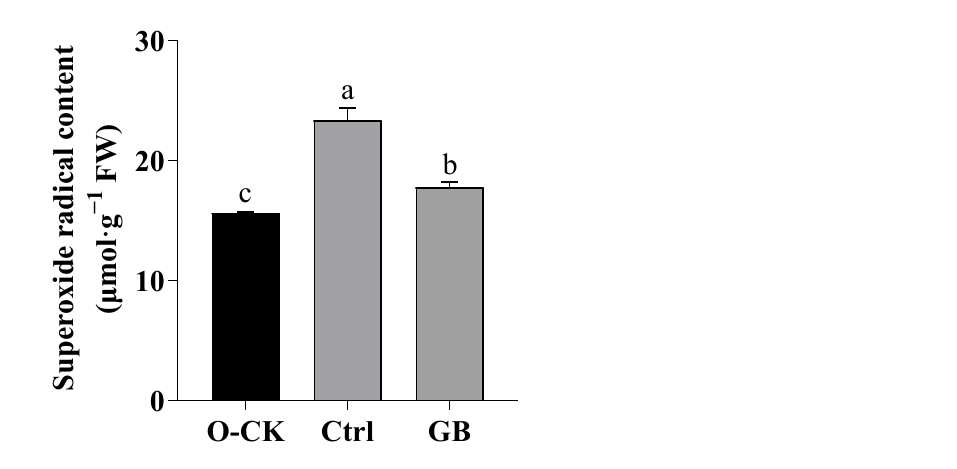
Figure 2. Effects of GB on O 2 ·− in B. rapa under heat stress. Data are shown as mean ± SD. Different lowercase letters indicate significant difference at p < 0.05. O-CK, optimum conditions, foliar sprayed with water; Ctrl, foliar sprayed with water before exposure to heat stress; GB, foliar sprayed with GB before exposure to heat stress.